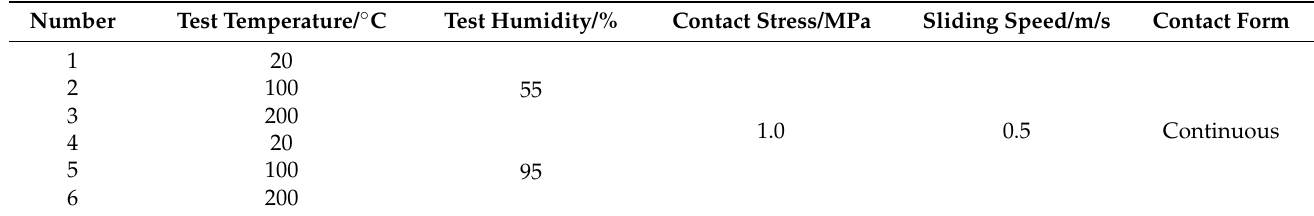
Table 2. Test parameters (repeated three times for each